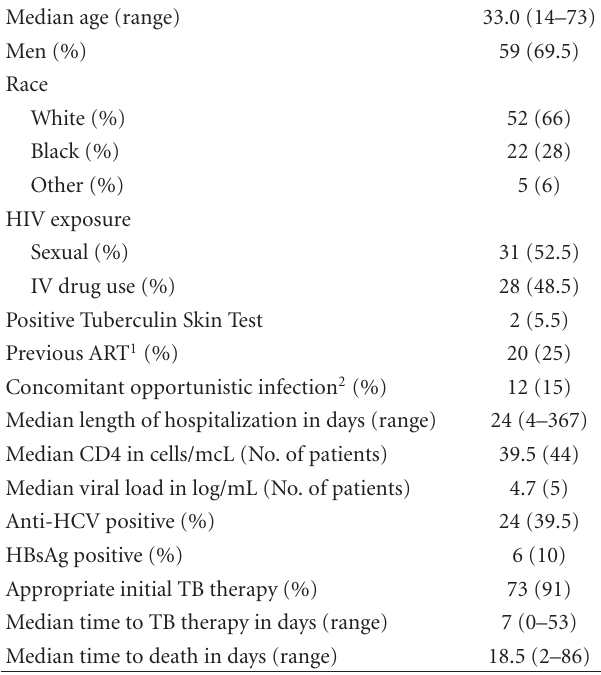
Table 1: Characteristics of the HIV-infected patients with dissemi- nated